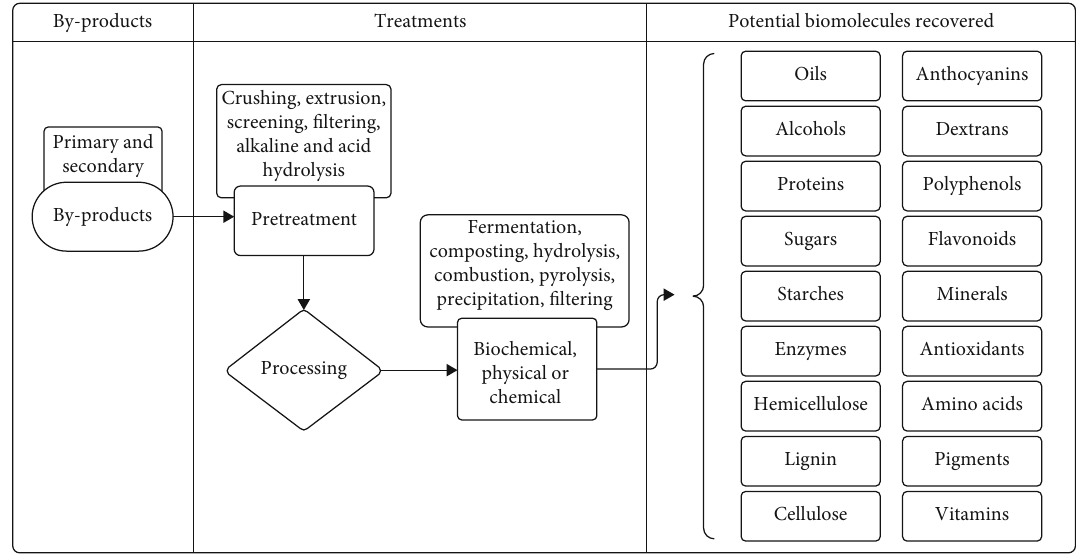
Figure 2: Potential biomolecules recovered from by-products using emerging